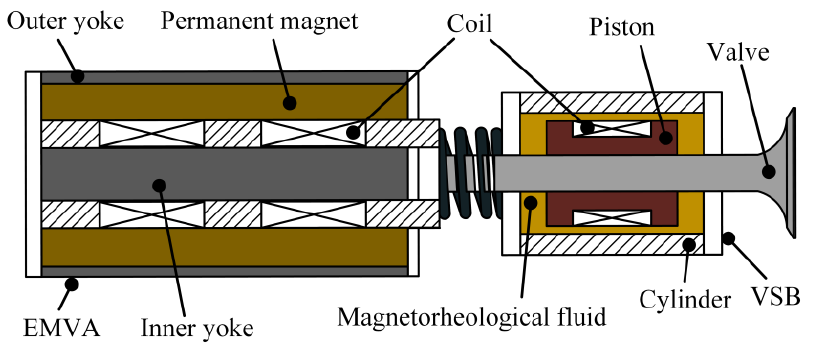
Figure 1. The structure of EMVV system.